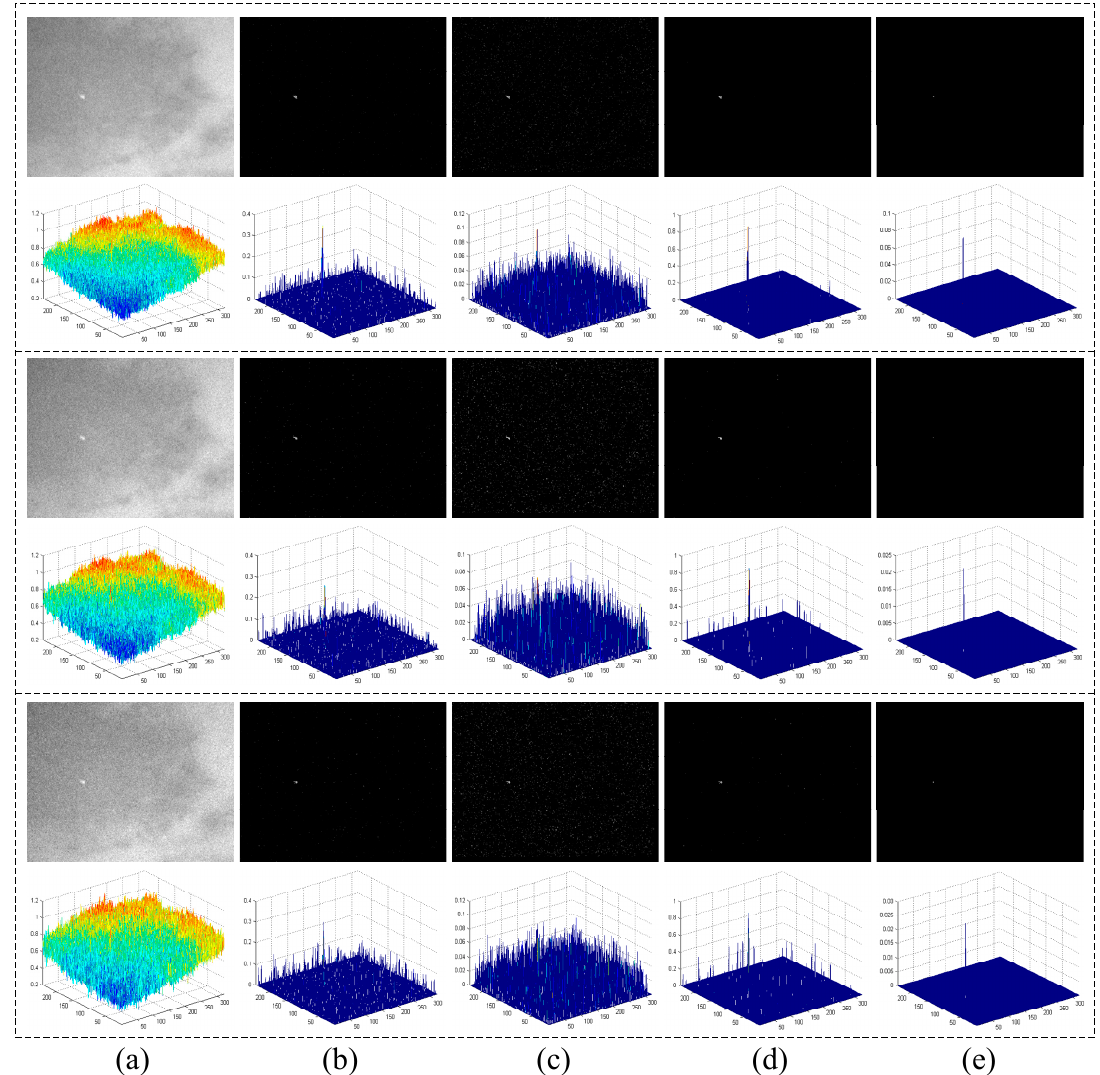
Figure 17. Comparison of processing results for Seq 2 noise images. The variance from top to bottom is 0.04, 0.05 and 0.06. (a) Noise image; (b) IPI processing result; (c) RIPT processing result; (d) NRAM processing result; (e) NOLC processing result.